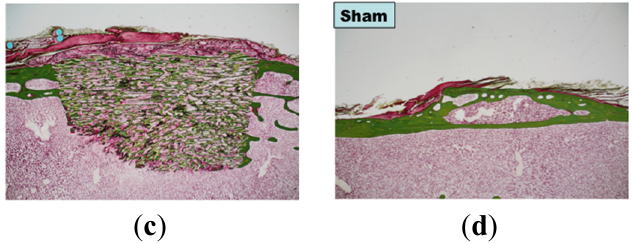
Figure 3. Histological findings undecalcified sections in Villanueva-Goldner staining at 104 weeks after UDPHAp transplantation ( a , b and c ). A sham-operated specimen is also shown ( d ). Bone is stained in green.